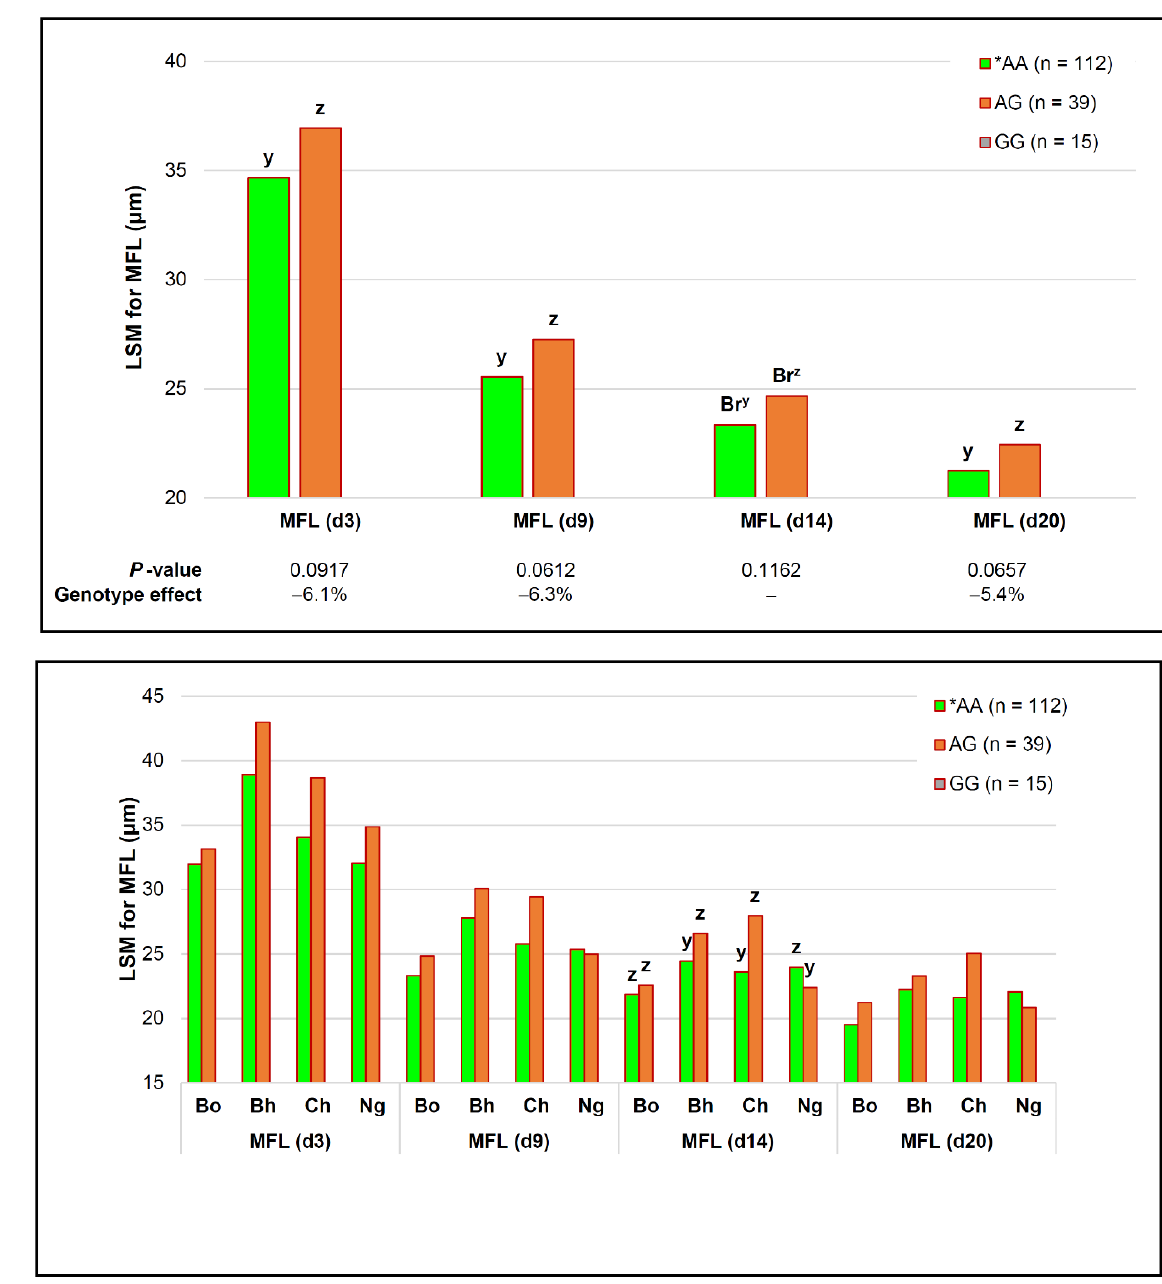
Figure 2. Additive effects of the capn2_780 genotype and ageing on myofibril fragment length (MFL). AA*—the genotype that favored tenderness. Within each ageing period, different descending letter superscripts (z, y, x) tended to be significantly different ( p ≤ 0.10): ( a ) genotype and ageing effects data pooled for all breeds; Br—different only when breeds were added to the simplified model; ( b ) genotype and ageing effects on MFL for individual South African beef breeds. Bo—